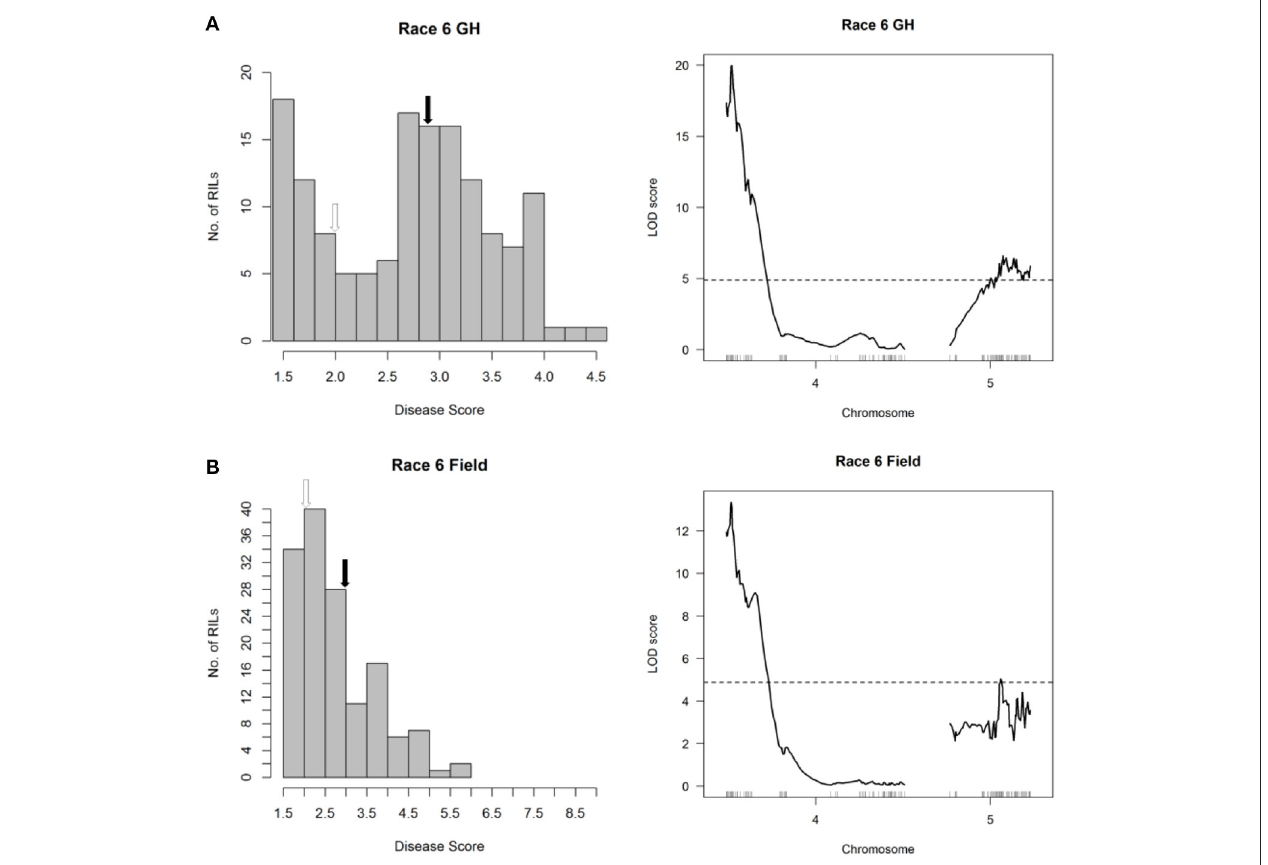
FIGURE 6 | Resistance mapping in the Phaseolus vulgaris Rojo × CAL 143 (RC) recombinant inbred population following inoculation with Race 6 of Pseudomonas syringae pv. phaseolicola (A) in the glasshouse and (B) in the field detects co-localizing QTL on Pv04 and Pv05. (Left graphs) Distribution of interaction phenotypes exhibited by RC inbreds in glasshouse and field experiments. The phenotype scale ranges from highly resistant (score 1.0) to fully susceptible (score 5.0 for glasshouse experiments; score 9.0 for field experiments). White arrows denote the mean disease score for CAL 143 and black arrows denote the mean disease score for Rojo. (Right graphs) LOD profiles obtained by one-dimensional and two-dimensional genome scans. QTL models were fitted and refined using the multiple imputation method. Dashed lines denote significance at the 0.05 probability